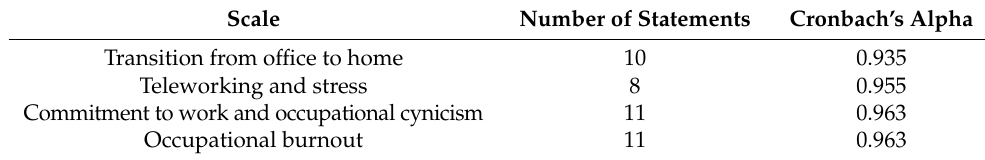
Table 2. Homogeneity of answers in questionnaire